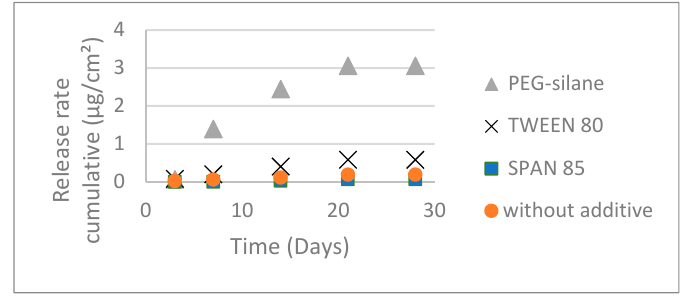
Figure 4. Release of thiocyanate copper from paints during immersion in distilled Figure 4 . Release of thiocyanate copper from paints during immersion of thiocyanate copper from paints during immersion in distilled water .